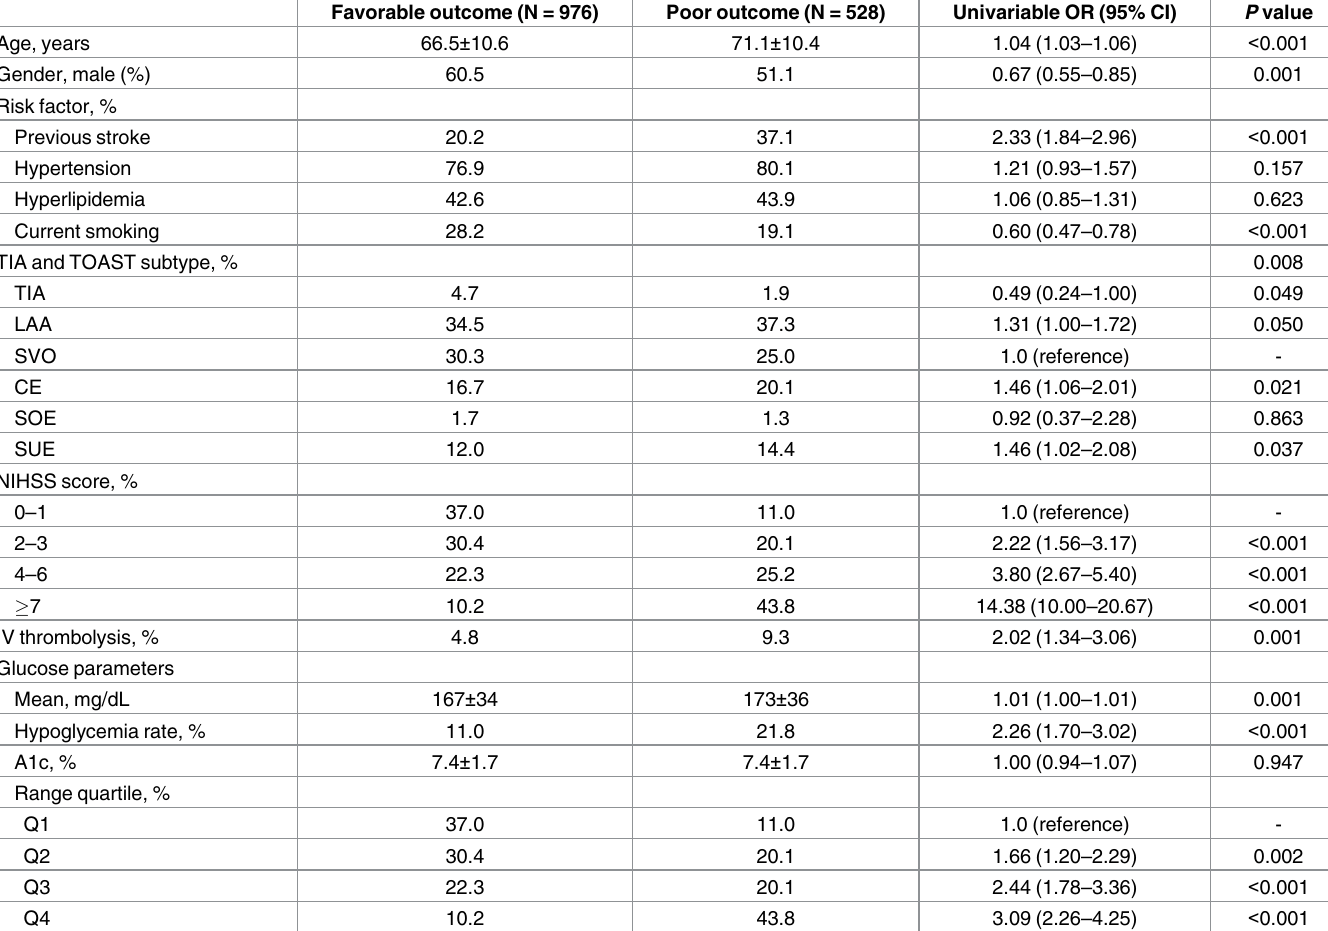
Table 3. Univariable analysesof the predictors of poor functional outcome at 3 months after stroke